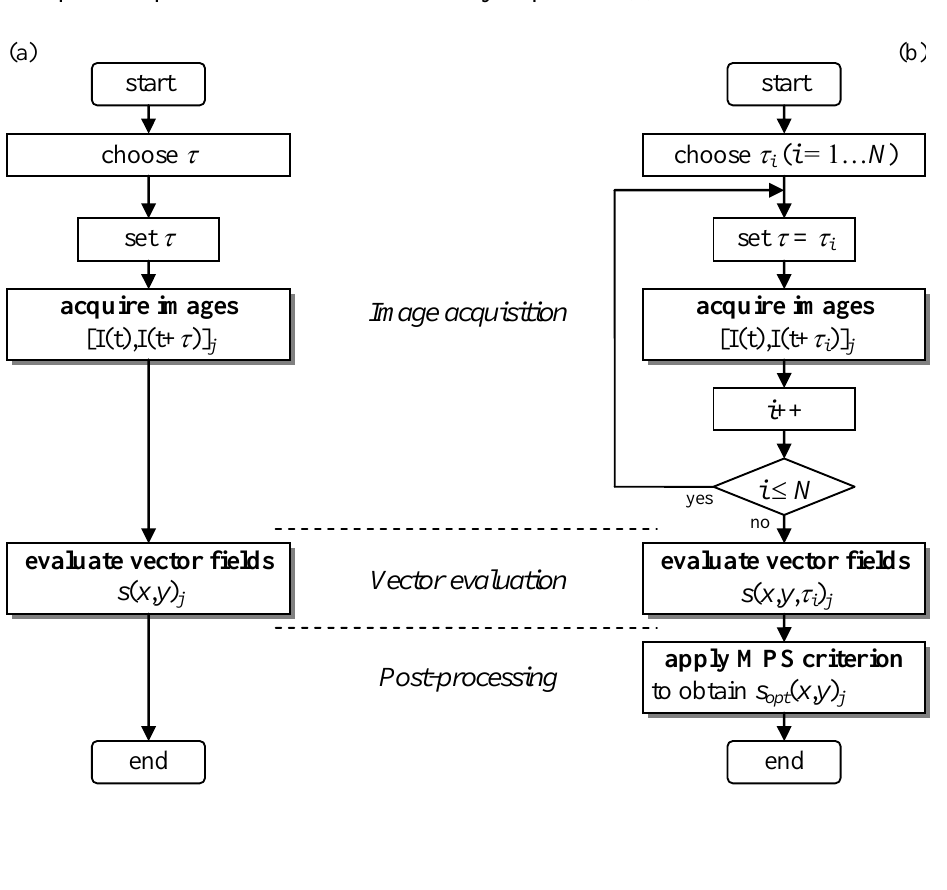
with optimal pulse separation criterion defined by Equation